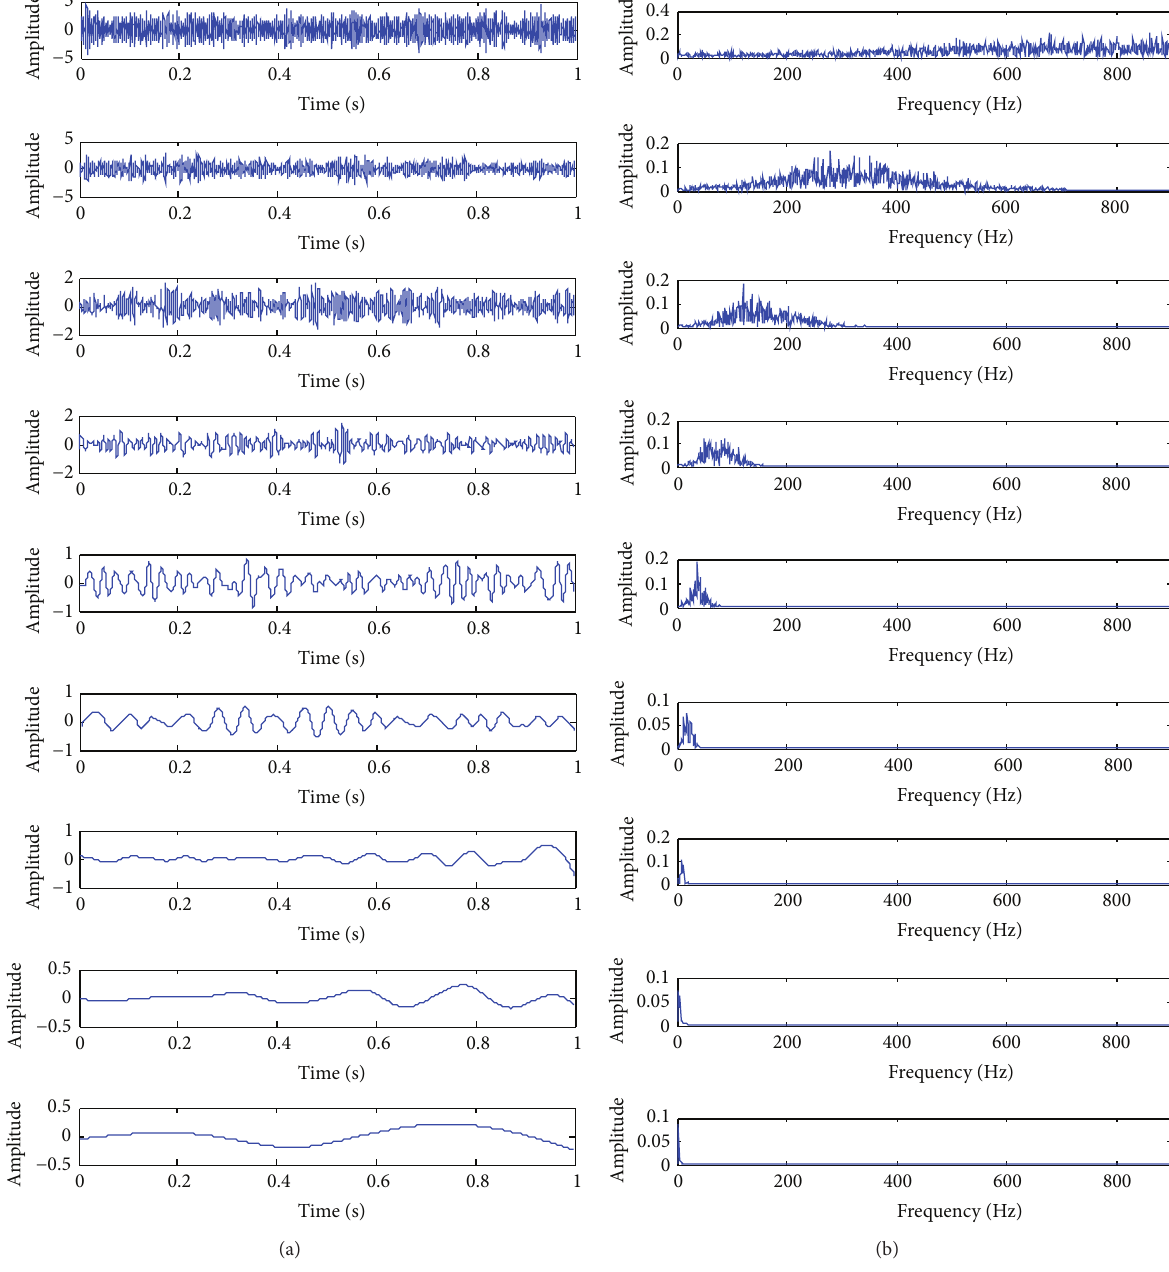
Figure 7: Result of the EEMD method for the simulation signal: (a) IMFs and (b) frequency spectra of